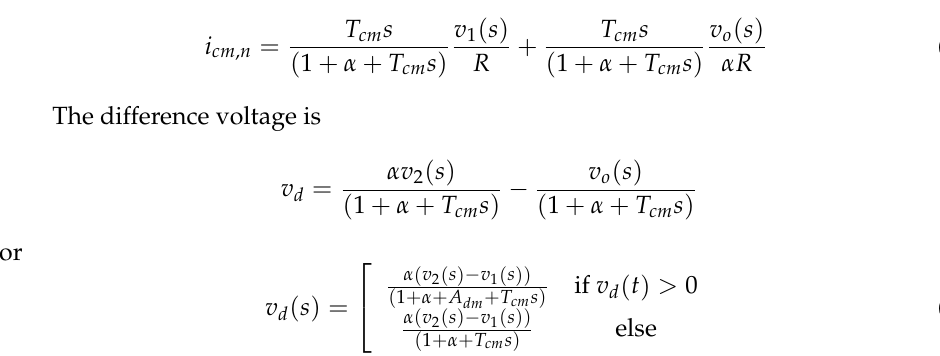
Figure 9. The cCCDA circuit.